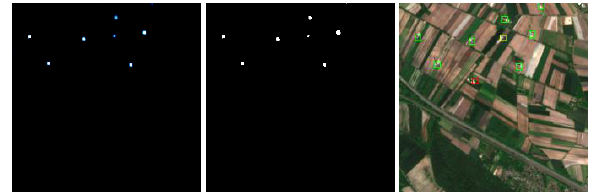
Figure 4 . U-Net probability map output (left), results with a threshold of 0.5 (middle), detection results overlaid on the original image